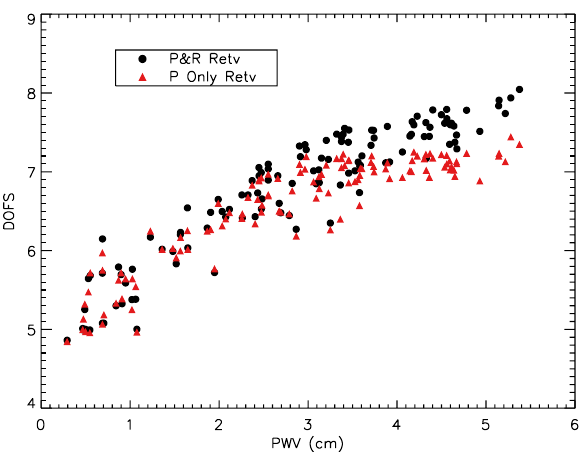
Fig. 24. Degrees of freedom for signal (DOFS) versus PWV for the P- and R-branch retrieval (black circles) and the P-branch-only retrieval (red triangles) of H 2 O using LBLRTM v12.1.